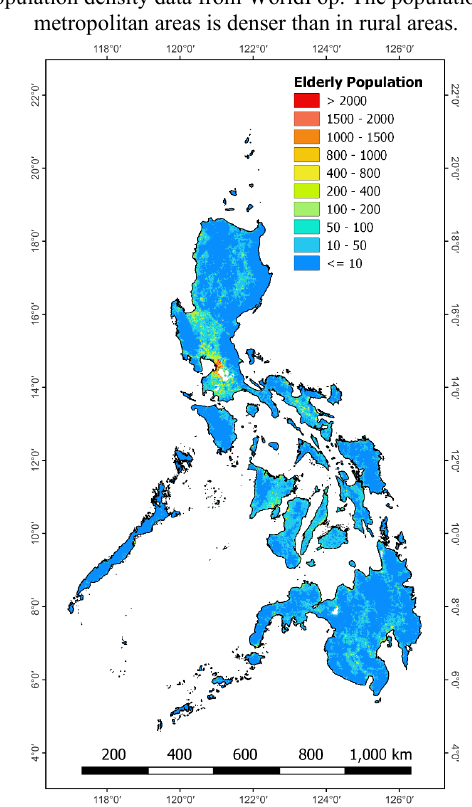
Figure 8. The dense population of elderly are found in urban areas, specifically in Metro